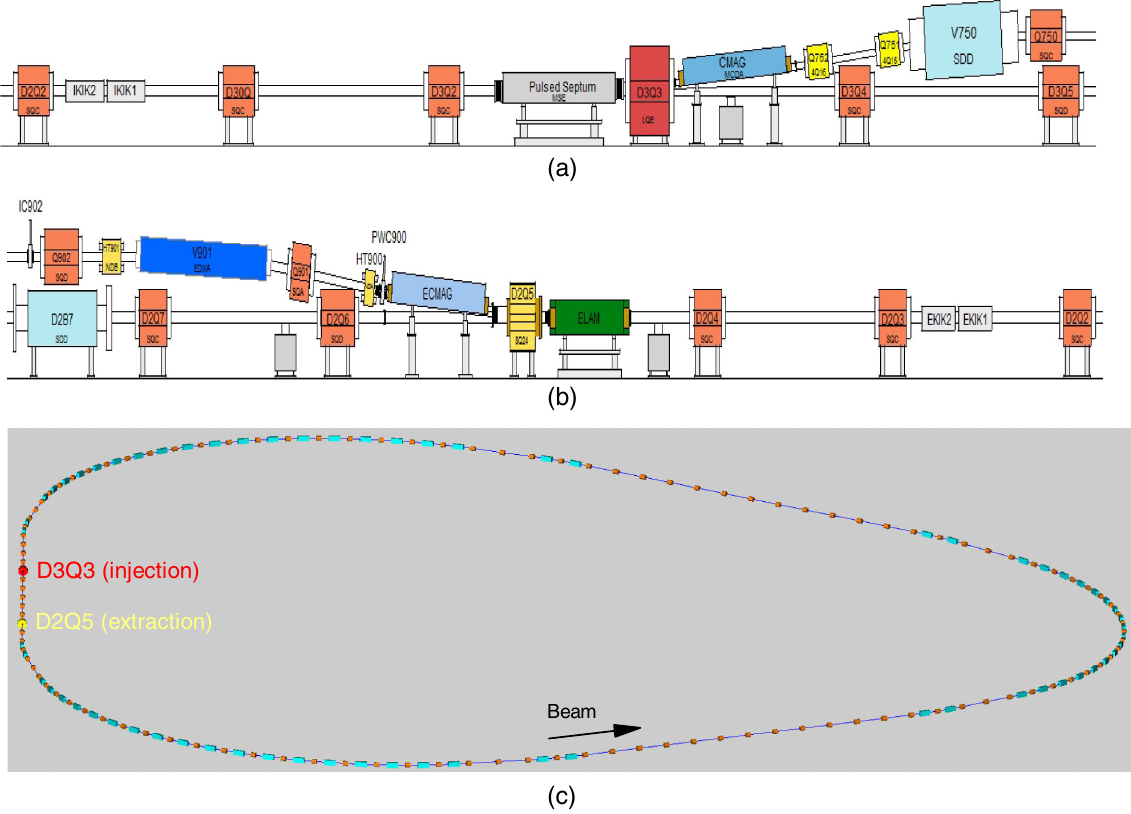
FIG. 3. (a) The conceptual design for injection into the DR, where the beam direction is from right to left. (b) The conceptual design for extraction from the DR, where the beam direction is from right to left. (c) A distorted image of the DR that shows all focusing elements, where the large aperture injection quad (D3Q3) is shown in red, extraction quad (D2Q5) is shown in yellow, all other quads are shown in orange, and bends are shown in cyan. Injection and extraction beam lines are omitted for the sake of